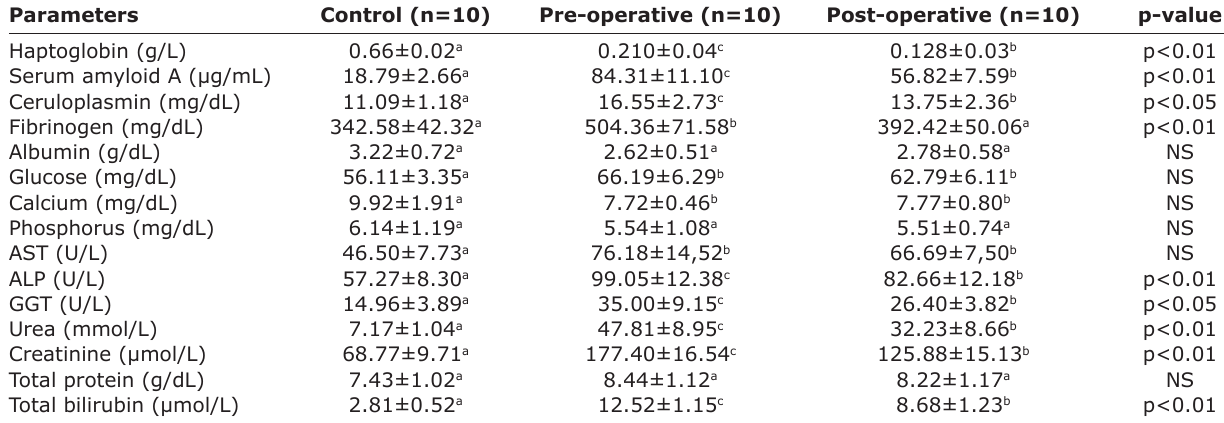
Table-1: Mean values and standard errors of acute phase protein and biochemical parameters in the calves with omphalitis (X±SEM).